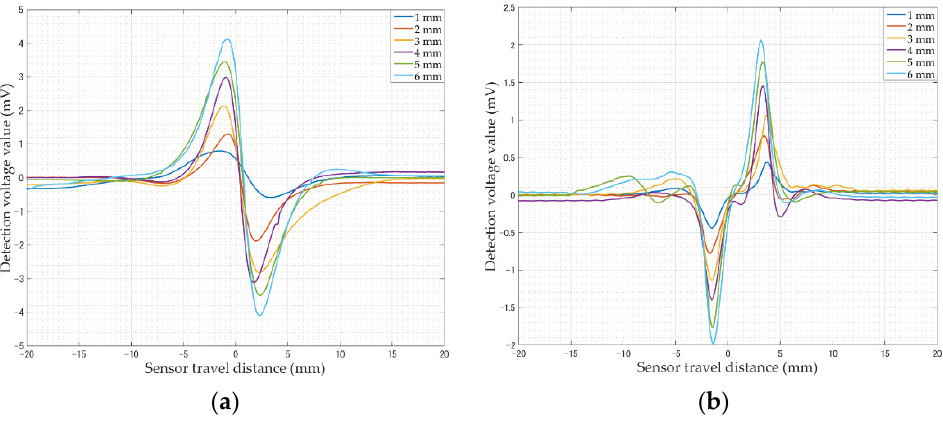
Figure 11. ( a ) Circumferential crack detection signal; ( b ) axial crack detection signal. To further analyze the relationship between crack depth and detection signal ampli- tude, differenced the peak value and valley value of the detection signal for each depth crack to obtain the relationship between crack depth and amplitude for circumferential and axial cracks on the pipeline surface, respectively, as shown in Figure 12.